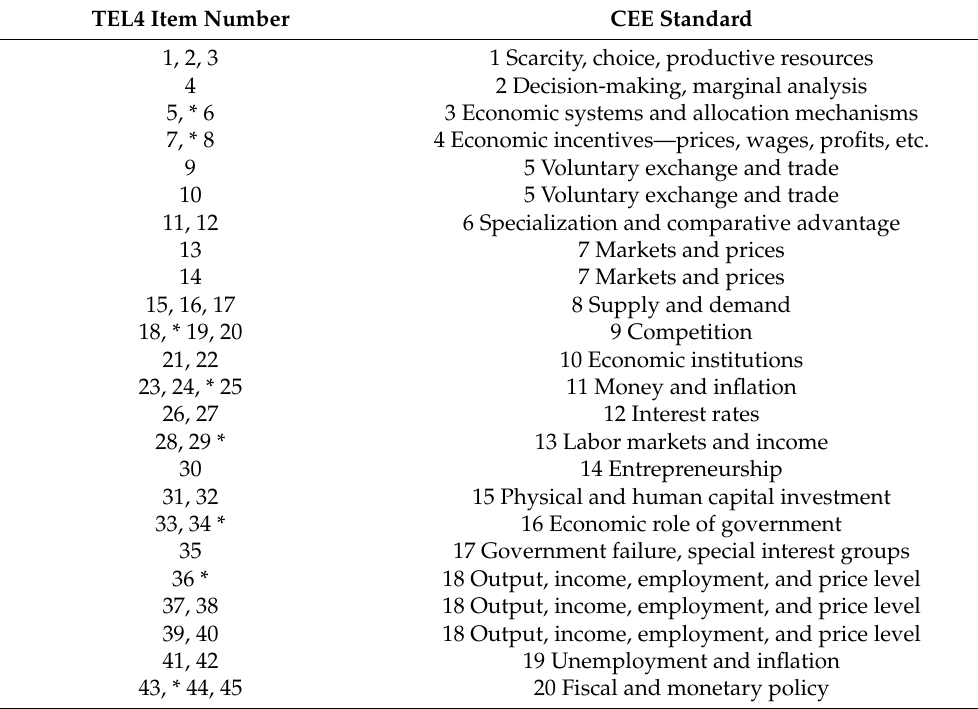
Table 1. CEE Standards and TEL4